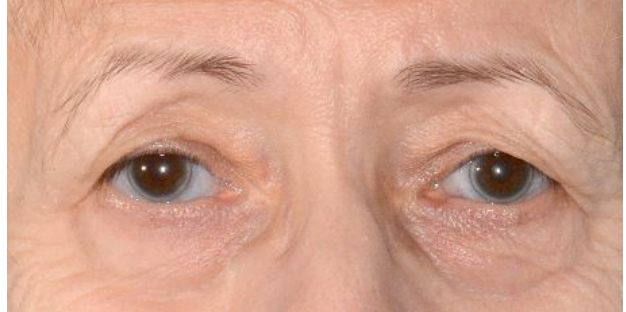
Figure 2. Characteristic bluish sclerae in a known case of osteogenesis imperfecta.